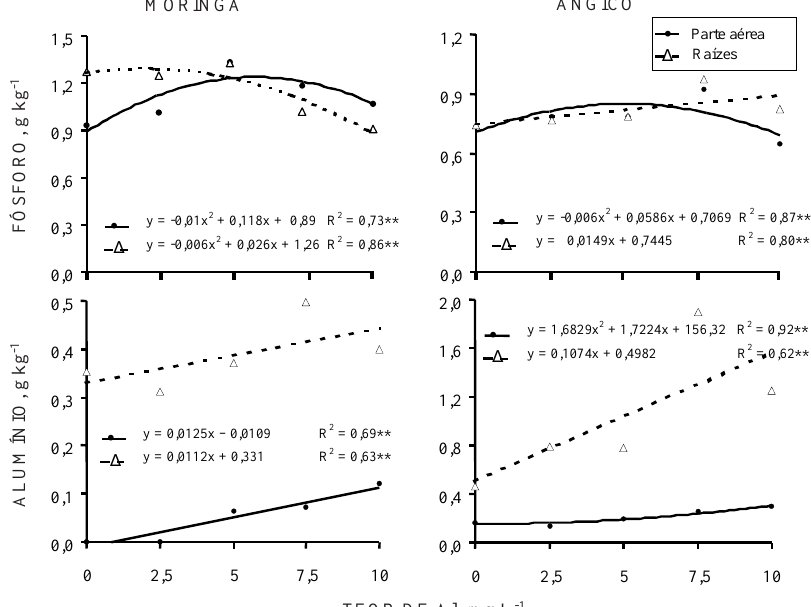
Figura 2. Teores de P e Al na matéria seca da parte aérea e das raízes da Moringa e do Angico em diferentes teores de Al na solução